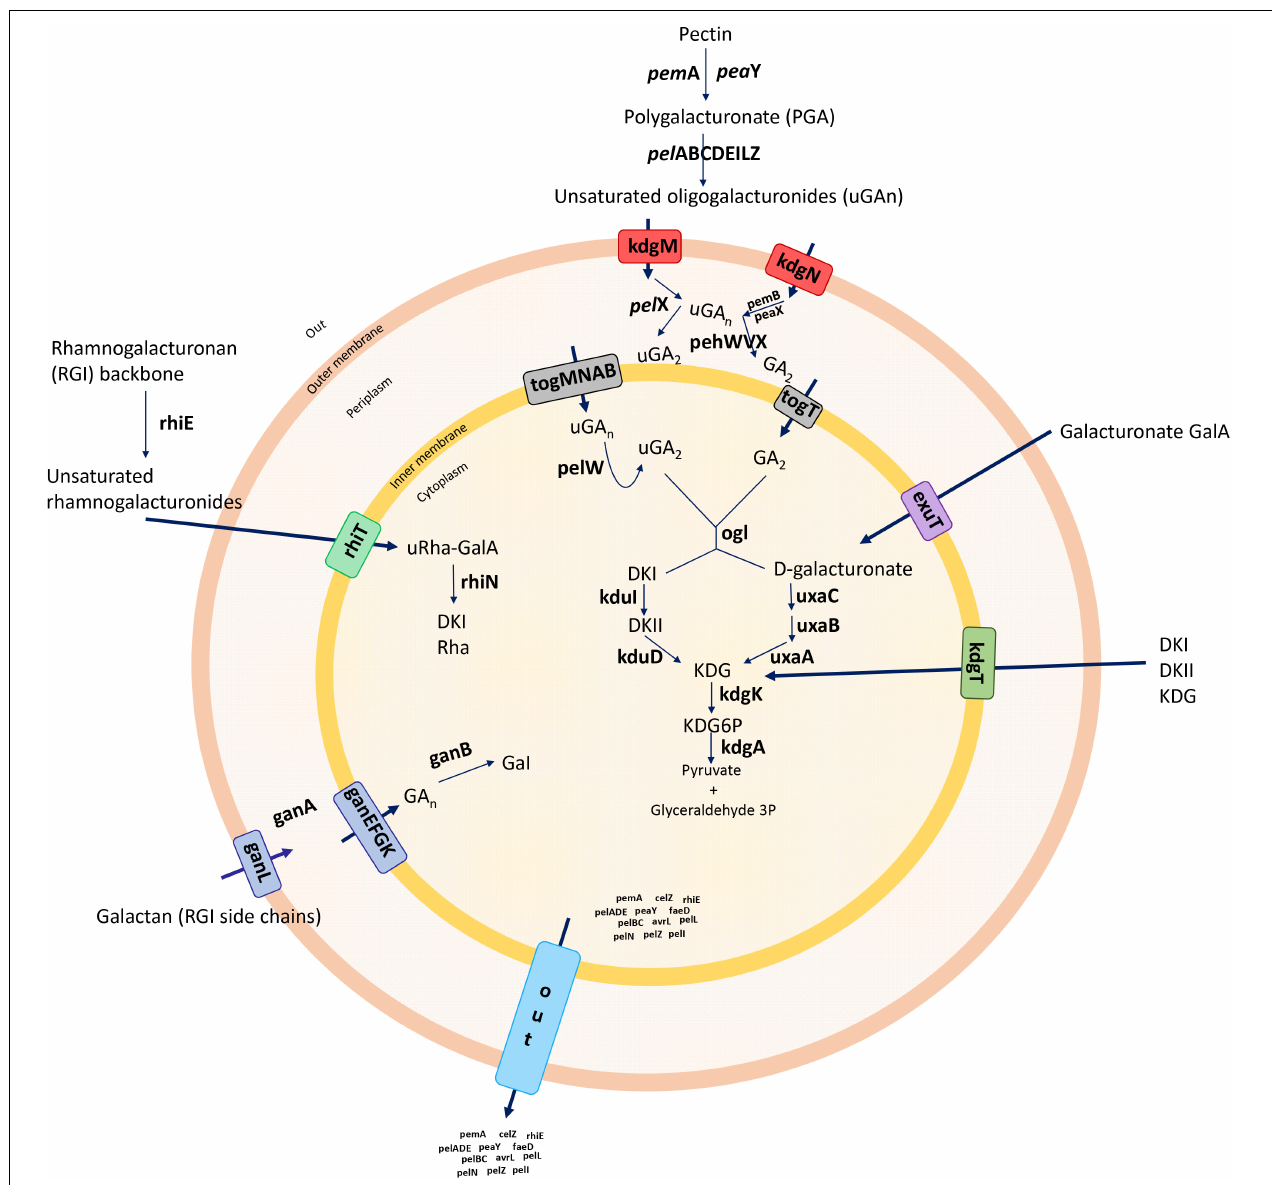
FIGURE 1 | Summary of the general pectin degradation pathway in soft rot